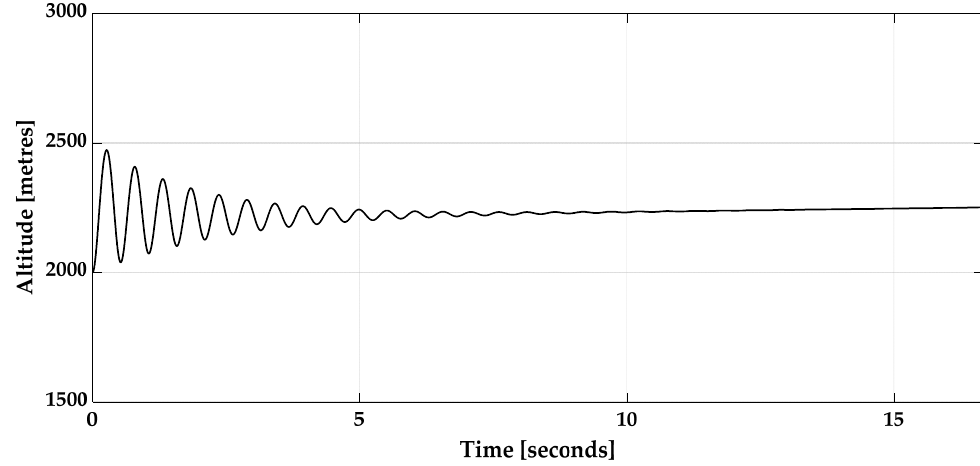
Figure 37. Pitch angle ( ϴ ) versus time plot for longitudinal stability case.